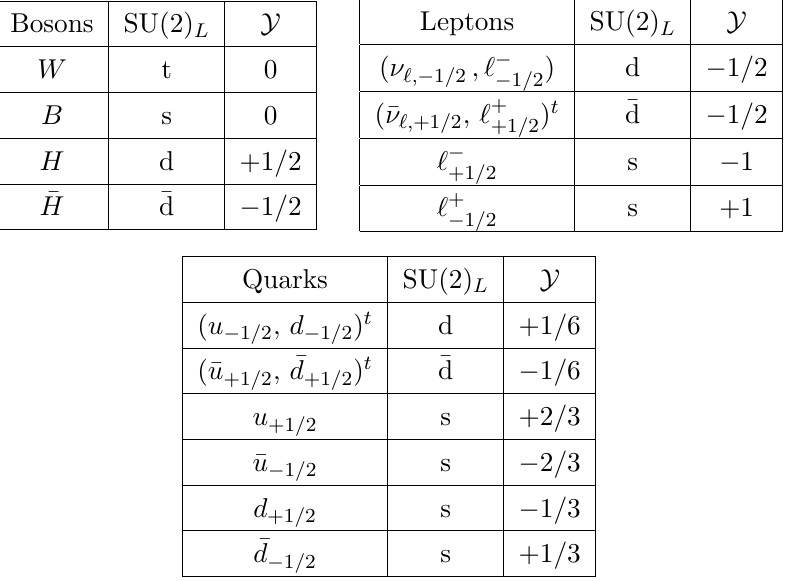
Table 6. SU (2) L × U (1) Y quantum numbers of the SM particles in the high-energy regime.